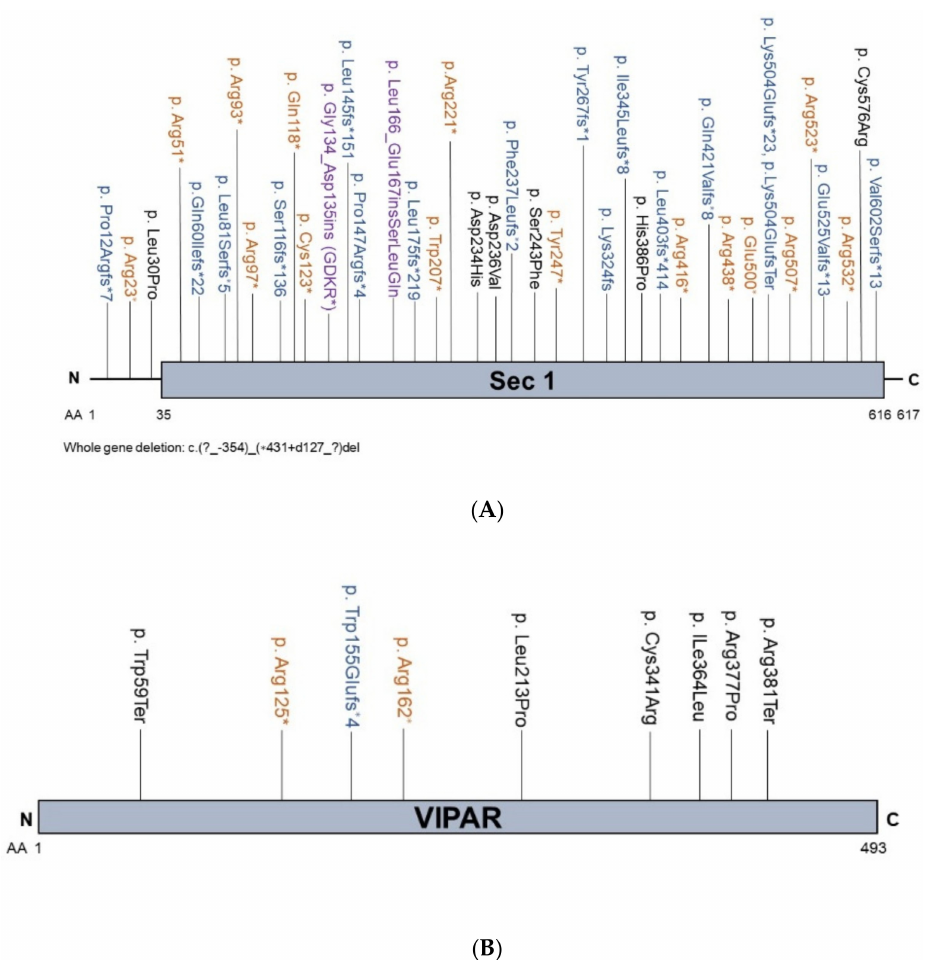
Figure 2. Overview of VPS33B and VIPAR protein mutations associated with cholestasis. ( A ): Cholestasis-associated mutations in the VPS33B protein and its domains. The SEC1 domain of VPS33B is shown. ( B ): Cholestasis-associated VIPAR protein mutations. N: aminoterminus; C: carboxylterminus. AA: amino acid; *: premature